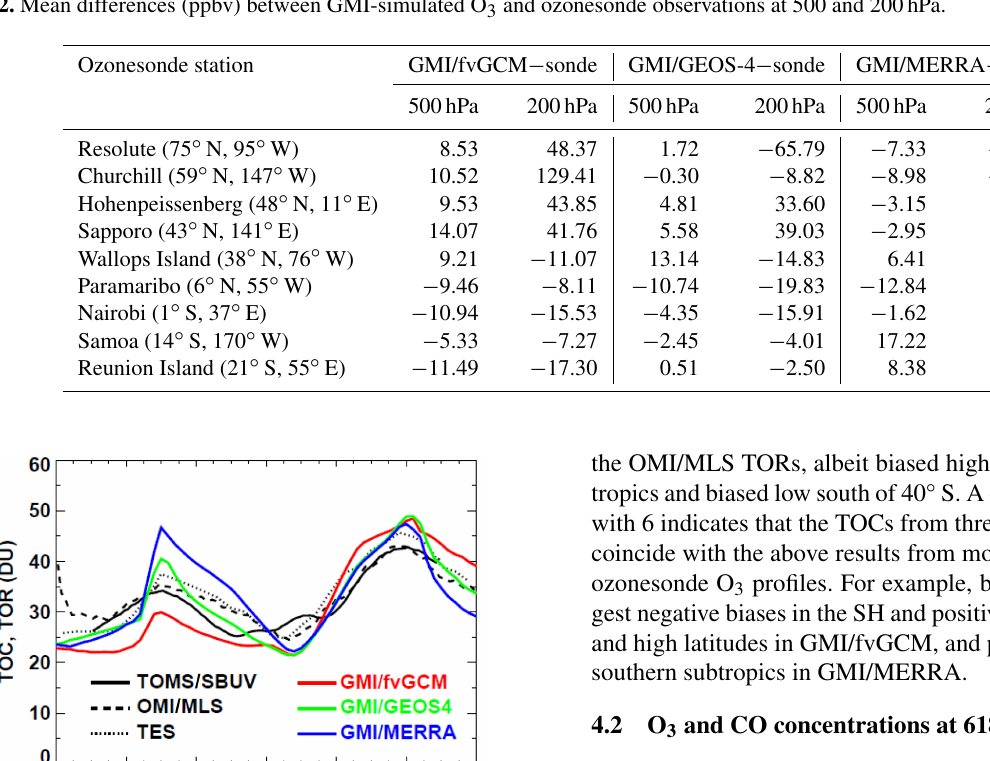
Table 2. Mean differences (ppbv) between GMI-simulated O 3 and ozonesonde observations at 500 and 200hPa.